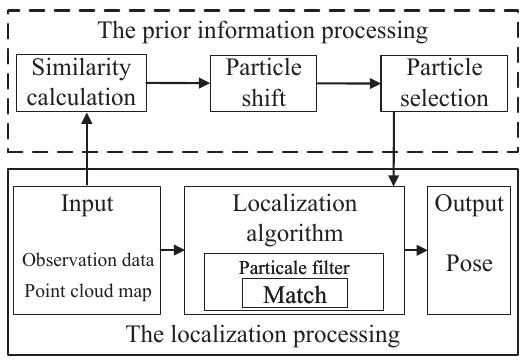
Figure 1. System